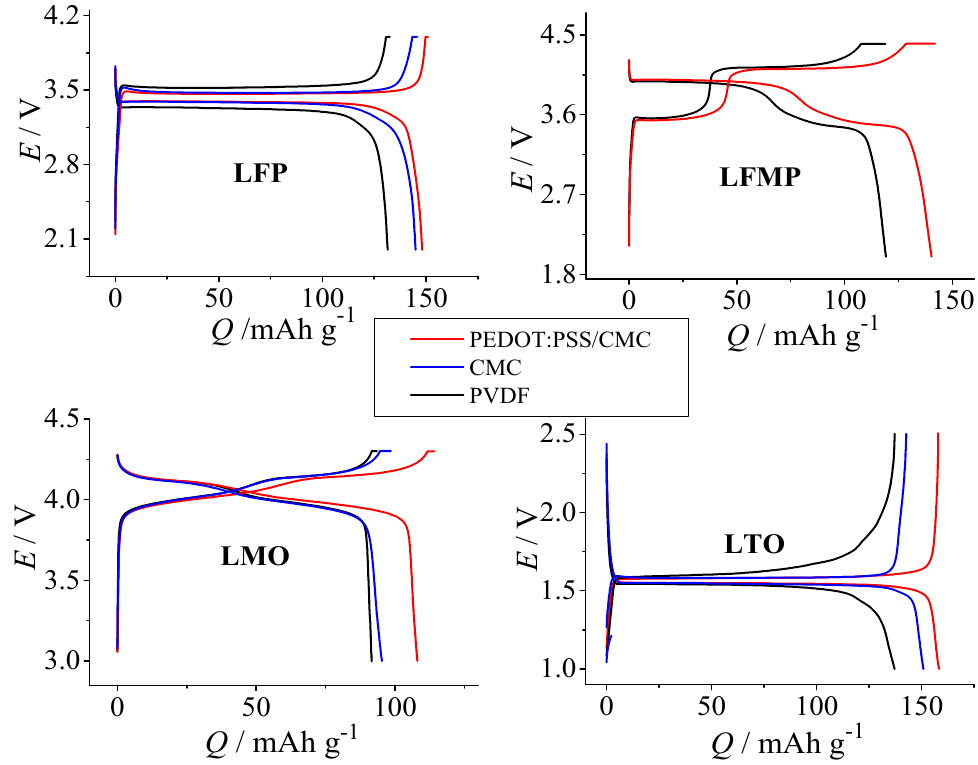
Figure 6. GCD curves of LFP, LFMP, LMO, LTO electrodes with PEDOT:PSS/CMC, CMC, and PVDF binders at 0.2 C (based on our data in Ref. [64–67]). Table 2. Specific capacities of electrodes with three binders (PEDOT:PSS/CMC, CMC, and PVDF) at 0.2 C.